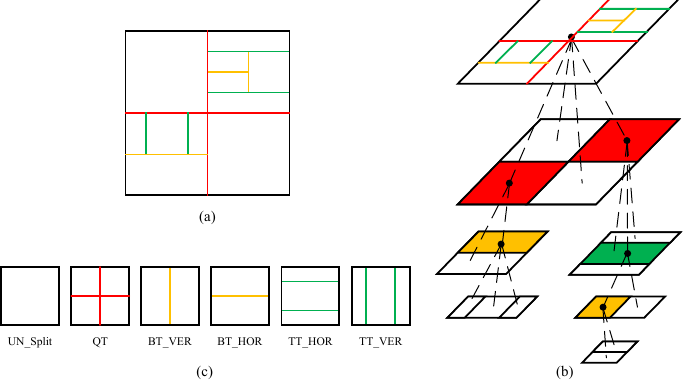
Figure 1. An example of optimal CU partition of a CTU. ( a , b ) denote the optimal CU partition, ( c ) presents six types of CU